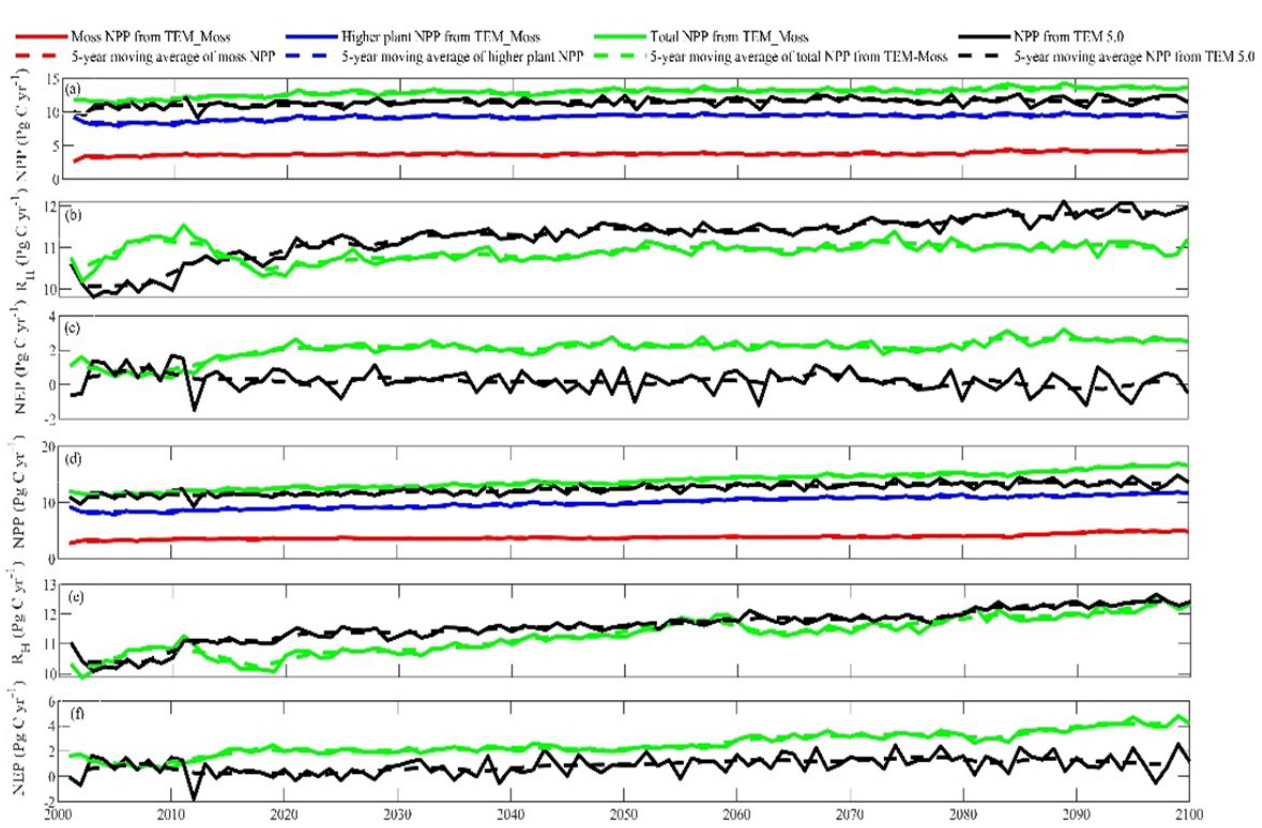
Figure 12. Predicted changes in carbon fluxes: annual net primary production (NPP, a , d ), heterotrophic respiration ( R H , b , e ), and net ecosystem production (NEP, c , f ) during the 21st century under the RCP2.6 scenario (a–c) and RCP8.5 scenario (d–f) by TEM_Moss and TEM 5.0. Table 12. Increase in SOC, vegetation carbon (VGC), and moss carbon (MOSSC) from 1900 to 2000 and total carbon storage during the 21st century predicted by two models under the (a) RCP2.6 scenario and (b) RCP8.5